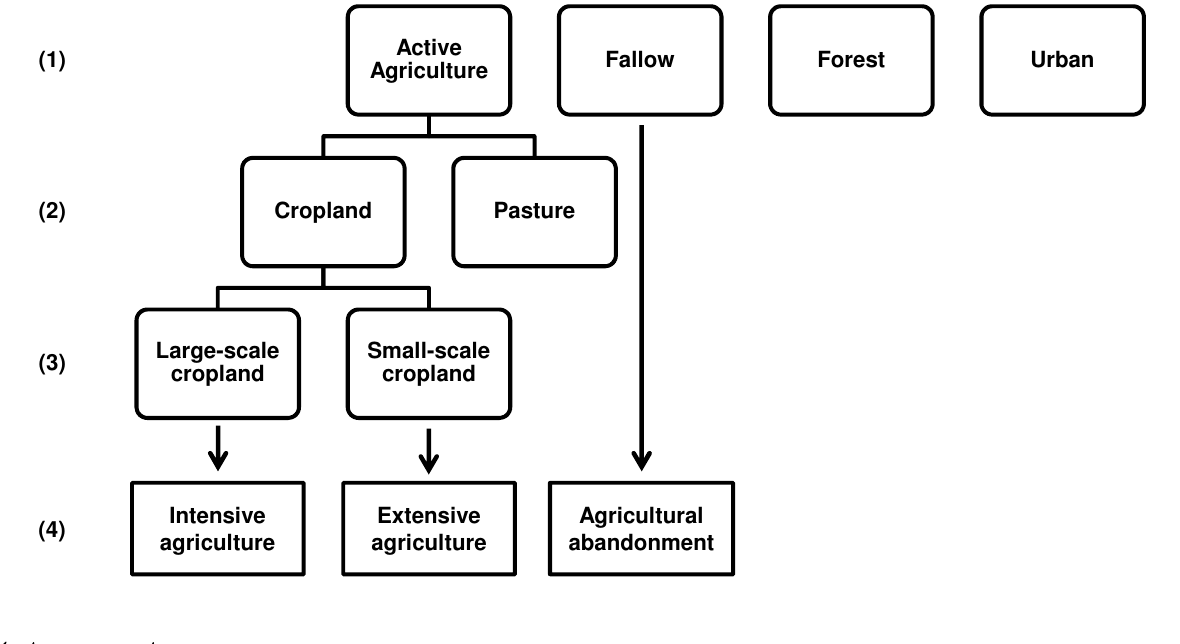
Figure 3. Diagram showing the hierarchical classification framework and derived indicators for management intensity. ( 1 ) Classification of active agriculture, fallow, forest and urban; ( 2 ) Classification of cropland and pasture within active agriculture; ( 3 ) Classification of large-scale and small-scale cropland; ( 4 ) Indicators of land management, derived from